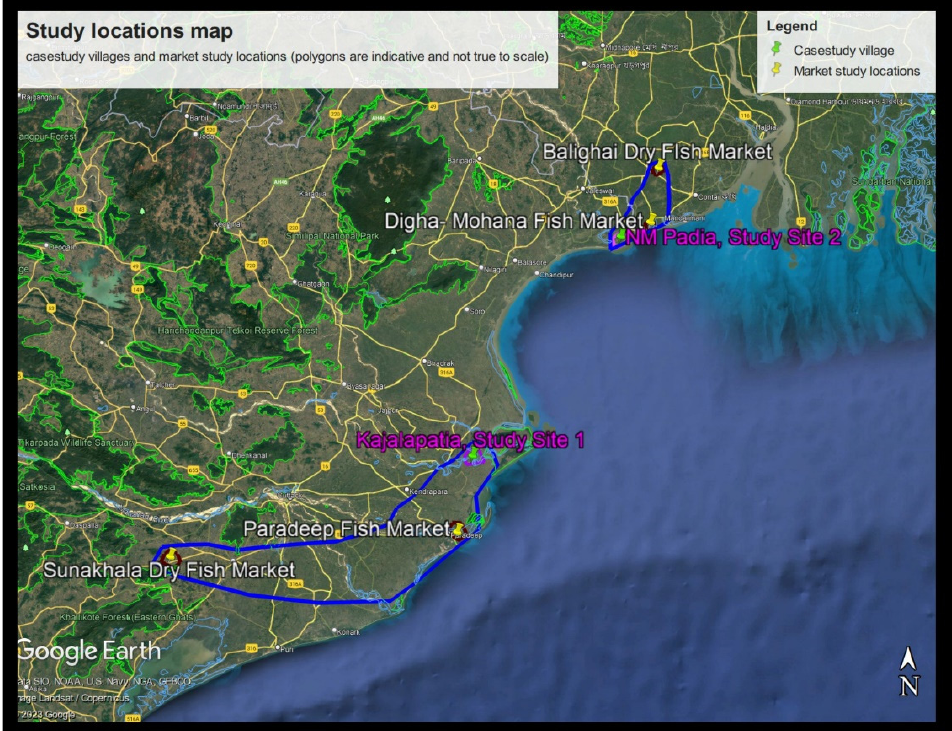
Figure 2. Map of study locations and case study sites indicating survey villages and dried fish mar- kets [Source: Google Earth Pro version 7.3.6.9345, (December 2022). Bay of Bengal Cost. Earth Ver- sions—Google Earth (https://www.google.com/earth/versions/#earth-pro, accessed on 27 January